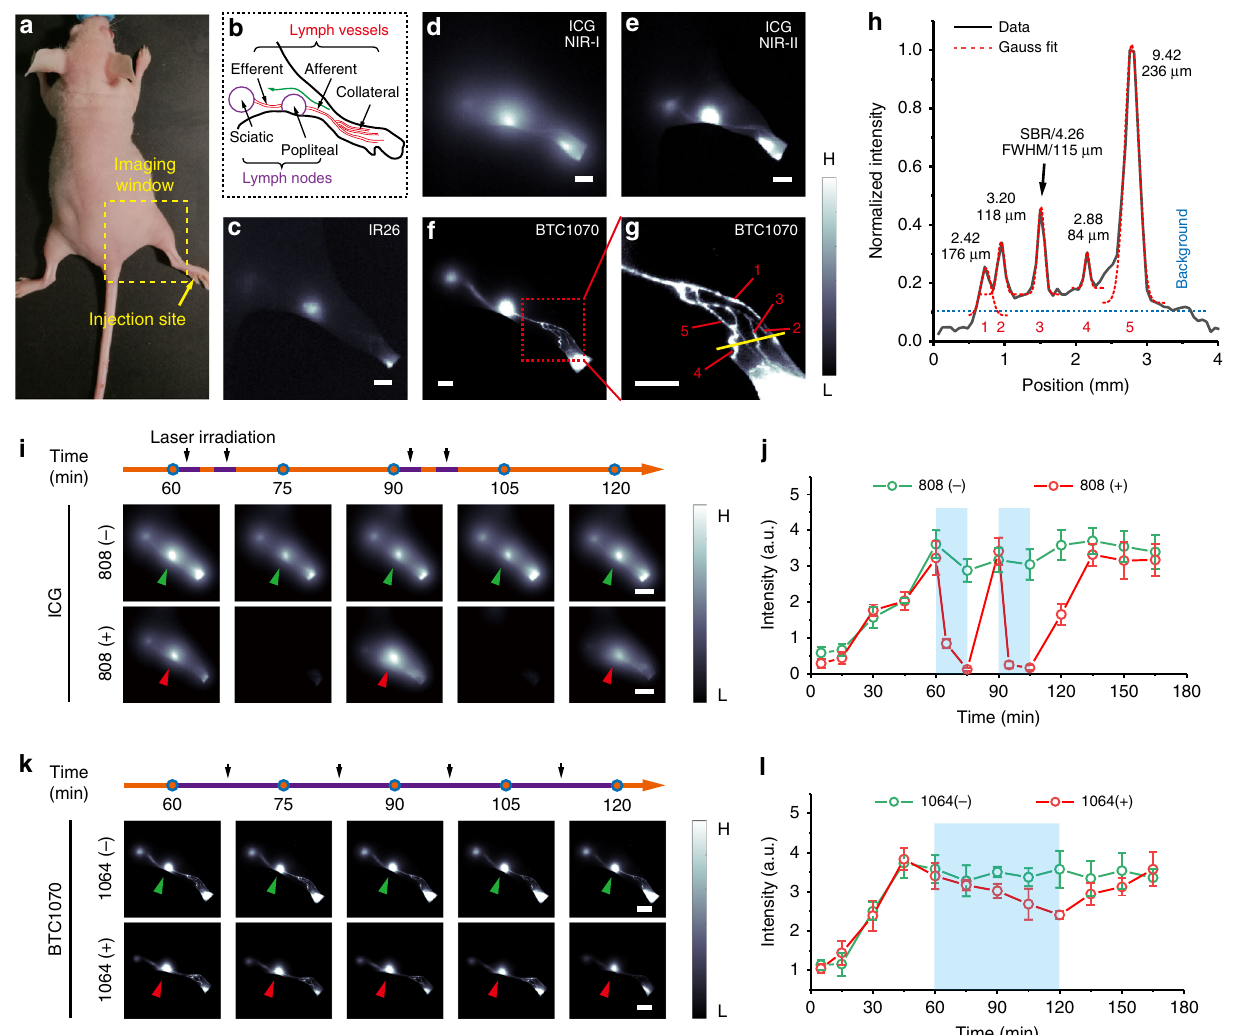
Fig. 4 Superior lymphatic imaging with BTC1070 to ICG and IR26. a Digital photograph of a nude mouse fi xed on imaging plate, showing the injection site (yellow arrow) of contrast agents and the lymphatic drainage imaging window (dash square). b Schematic illustration of the anatomical structure of lymphatic system in the hindlimb of nude mice, green arrow represents the lymphatic drainage from the paw to the sciatic lymph node. c – g Fluorescence images of lymphatic drainage using IR26 c , ICG d , e , and BTC1070 f , g as contrast agents in the hindlimb of nude mice on an InGaAs camera. Scale bar, 2.5 mm. IR26 and BTC1070 imaging signals were collected at wavelength of 1200 – 1700 nm under 1064 nm excitation. ICG was excited at 808 nm, and images were collected in the NIR-I (850 – 950 nm) and NIR-II (1000 – 1700 nm) region, respectively. g High-magni fi cation (× 3) image of the ankle (red square in f ), showing at least fi ve collateral lymph vessels were resolved. h Cross-sectional fl uorescence intensity pro fi les (black solid) and Gaussian fi t (red dotted) along the yellow bar in g . i – l In vivo photobleaching studies of ICG and BTC1070. i , k Fluorescence images of lymphatic drainage at different time points post-injection using ICG i /BTC1070 k . 808 ( + )/1064 ( + ) represents that the 808/1064nm laser irradiation was conducted according to the set on the time line (purple segments on orange lines, each segment in i represents 3 min) with the same fl uence rate ( ~ 150 mW cm − 2 ), whereas 808 ( − )/1064 ( − ) represents no laser irradiation was conducted. Scale bar, 5 mm. j , l Fluorescence intensity signals of popliteal lymph nodes (green arrows/ red arrows in i , k ) versus time. Blue rectangles represent time windows of laser irradiation. Color bar ranges from 1000 to 30,000 for d – f , i , and k , 500 – 5000 for c , 2000 – 20,000 for g . The detailed imaging parameters for each image are listed in Supplementary Table 1. The bars represent mean ± s.d. derived from n = 3 biologically independent mice. Source data are provided as a Source Data fi Mice were administrated simulated gastric fl uid with different pH wrapped in a thin gastric wall ( ~ 1 mm depth, Fig. 7b) and (pH 1.3 and pH 2.5) to mimic the pH environment of human imaging of exposed gastric fl uid (0 mm depth, Fig. 7c). Further- stomach. Following gavage of BTC1070 micelle solution, the mice more, tissue thickness has negligible in fl uence on the ratio values were anaesthetized and further imaged on an InGaAs camera of each group (Supplementary Figure 25, 26). We then converted under 808-nm excitation. As shown in Fig. 7a, noninvasive the ratios to pH values by means of the calibration curves ratiometric imaging not only recognizes stomach pro fi le from the (Supplementary Note 3). The results show good agreement with left lateral aspect of the abdomen, at a tissue depth of ~ 2 – 4 mm that measured by standard pH meter, and the differences between (Supplementary Figure 24), but also differentiates the two pH them ( Δ pHs) are determined to be lower than 0.18 and 0.22 pH environments with sharp pseudo-color contrast. Similar results units for low (pH = 2.10 ± 0.11) and high pH groups (pH = 3.08 also emerge in invasive ratiometric imaging of gastric fl uid ± 0.27), respectively (Fig. 7d, Supplementary Table 7). By the